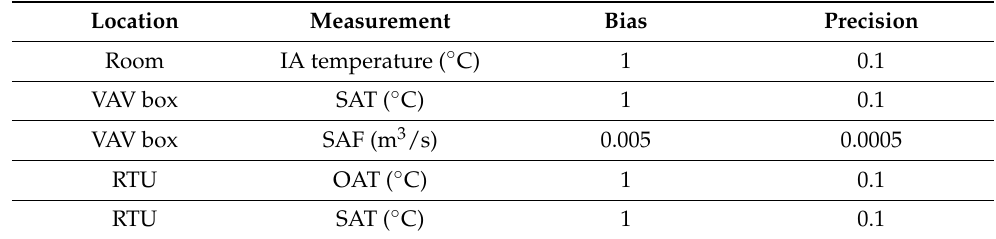
Table 4. Standard deviation of selected sensor